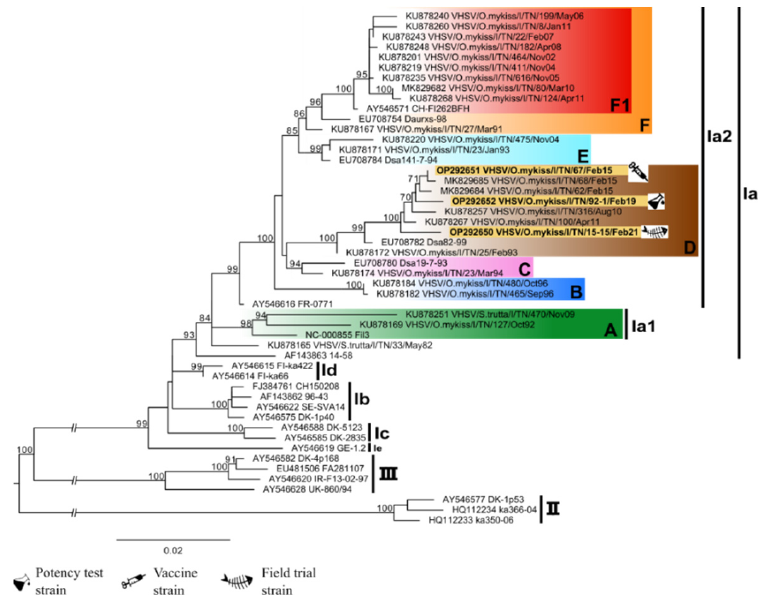
Figure 2. Phylogenetic tree based on the complete G gene sequence of VHSV. The strain used for the plasmid production, the strain used for the potency test, and the strain isolated during the field trial are highlighted in yellow. Vertical lines indicate the division into different genogroups and sub-lineages. The colored boxes highlight the different genetic clusters identified within sub-lineages Ia1 and Ia2 [19,26]. The posterior probability values ≥ 70 are reported for each node. The scale bar indicates the number of substitutions per site.